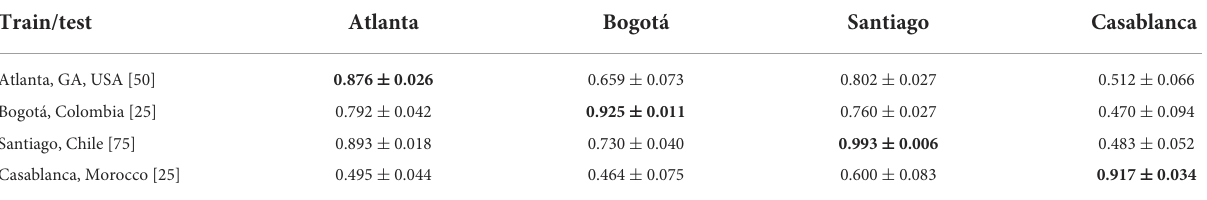
TABLE 3 Performance of classification in terms of ROC-AUC score with classifier trained on city in row and tested on the city in column, with diagonal showing “native” classifiers. Train/test Atlanta Bogotá Santiago